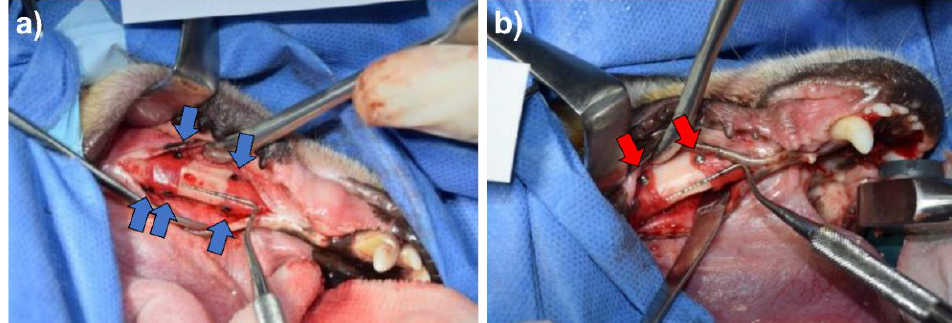
Figure 1. Representative surgical photos for the implantation of ( a ) the magnesium fixation screw and ( b ) the titanium fixation screw, when used to fixate a collagen membrane in a GBR procedure in the lower left jaw in beagle dogs. In both images, two treatment sites are partially visible. The magnesium screws (indicated by the blue arrows) appear black due to their magnesium fluoride surface, whereas the titanium screws appear silver shiny (indicated by the red arrows).